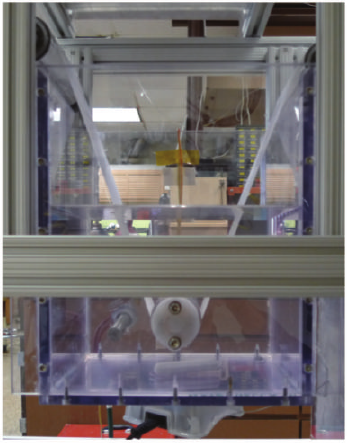
Figure 5: The preswelling